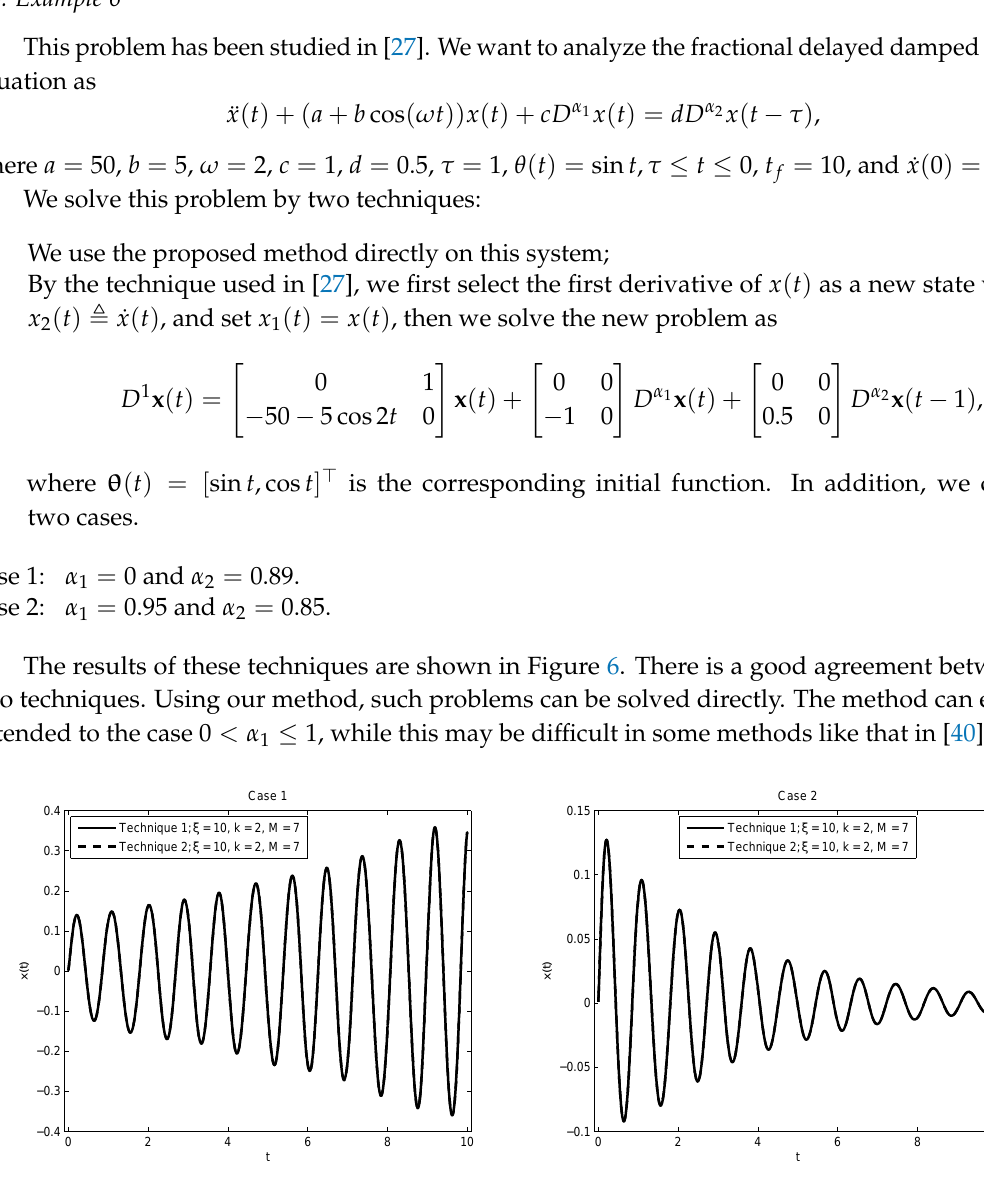
Figure 6. Solutions of Example